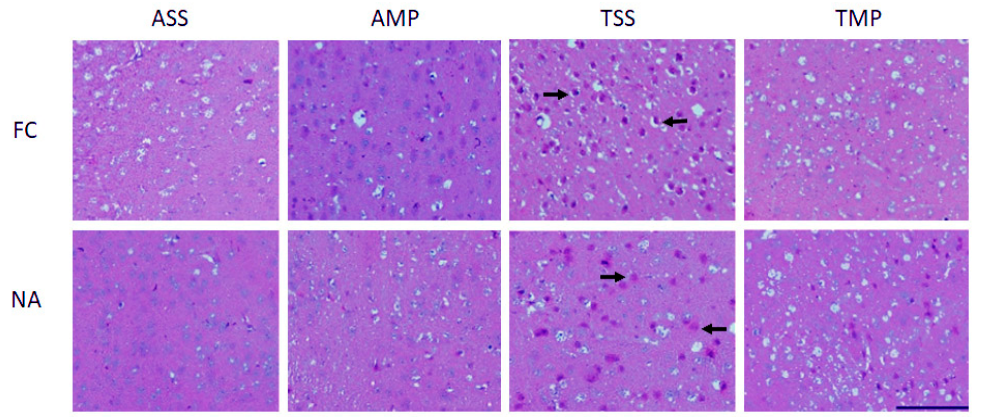
Figure 5. Histological examination of brains of mice repeatedly exposed to toluene and those with a previous exposure toluene and then treated with methylprednisolone. Hematoxylin-eosin stains of brain sections at frontal cortex (FC) and nucleus accumbens (NA). Scale bar represents 100 μ m. Air + saline solution (ASS); air + methylprednisolone (AMP); toluene + saline solution (TSS); toluene + methylprednisolone (TMP). Arrows show nuclear damage in TSS group in both FC and NA re- gions. Treatment with IN-MP reduced nuclear damage (TMP).